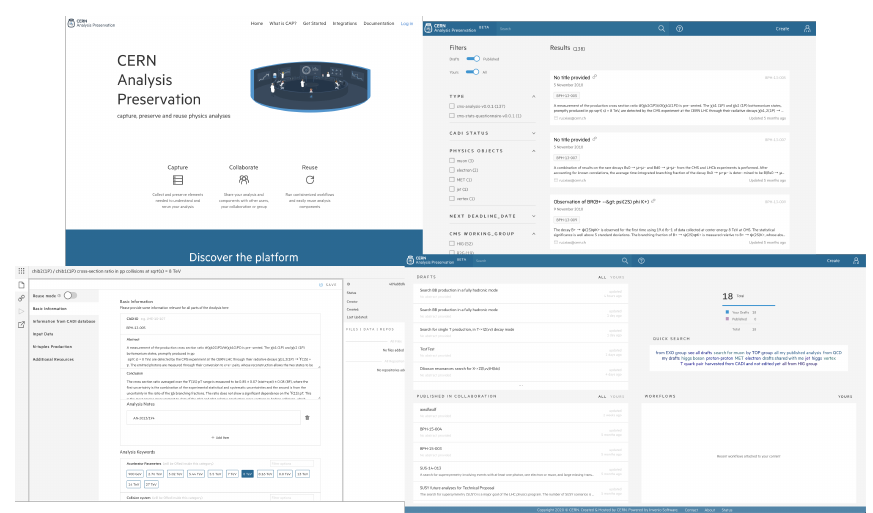
Figure 1: The CERN Analysis Preservation web